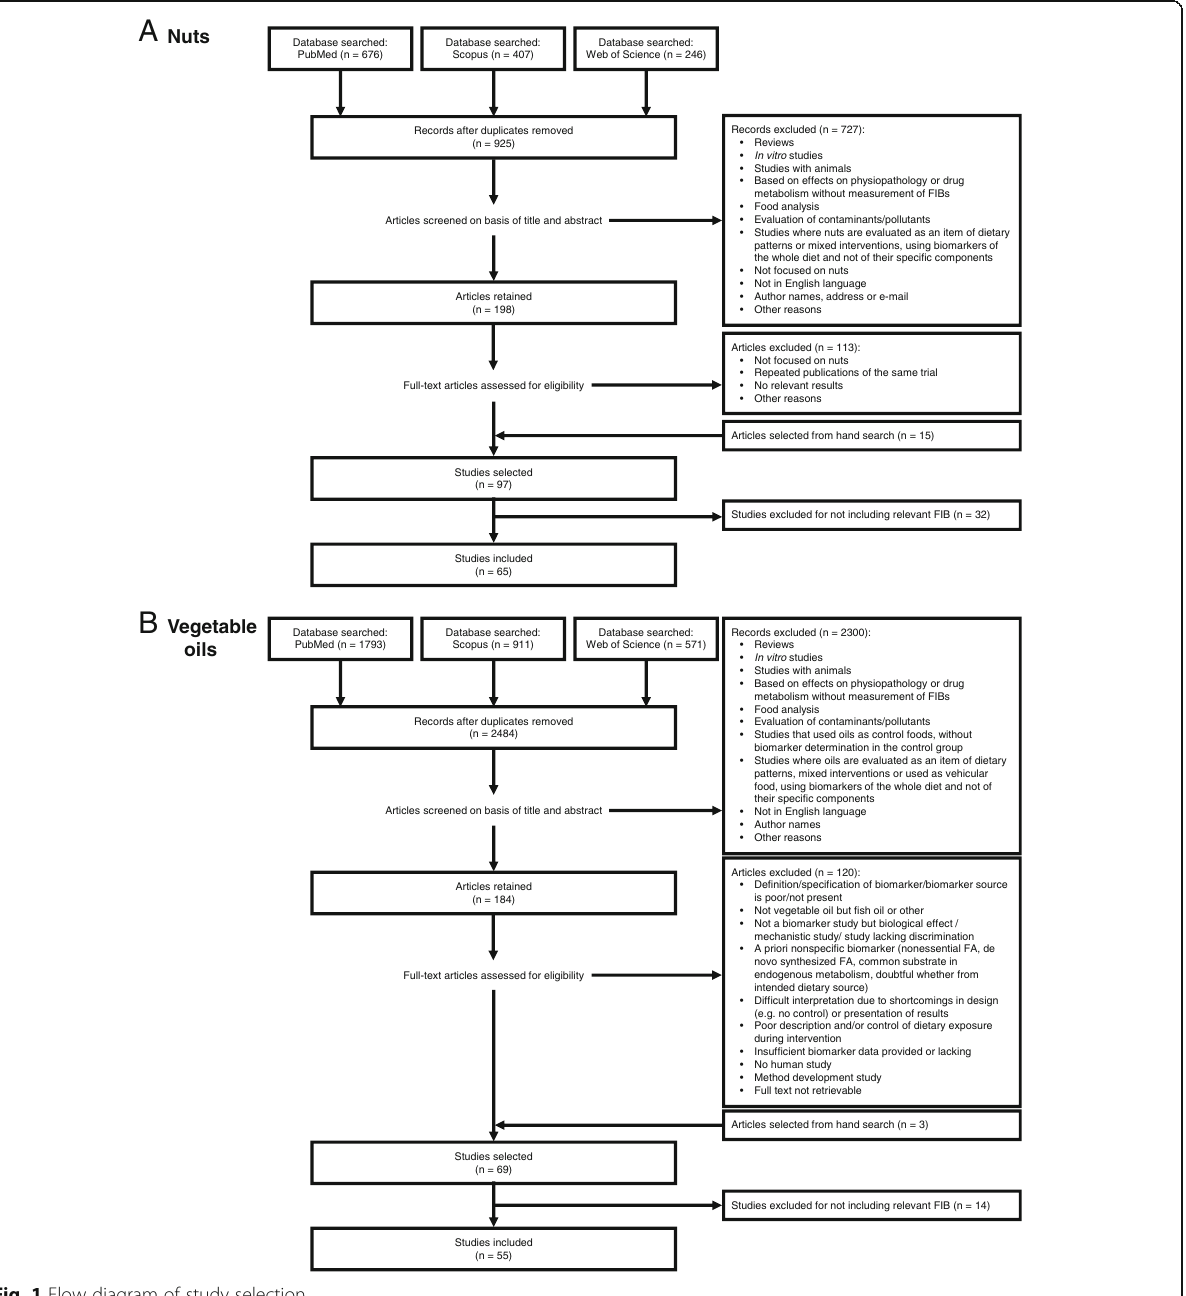
Fig. 1 Flow diagram of study